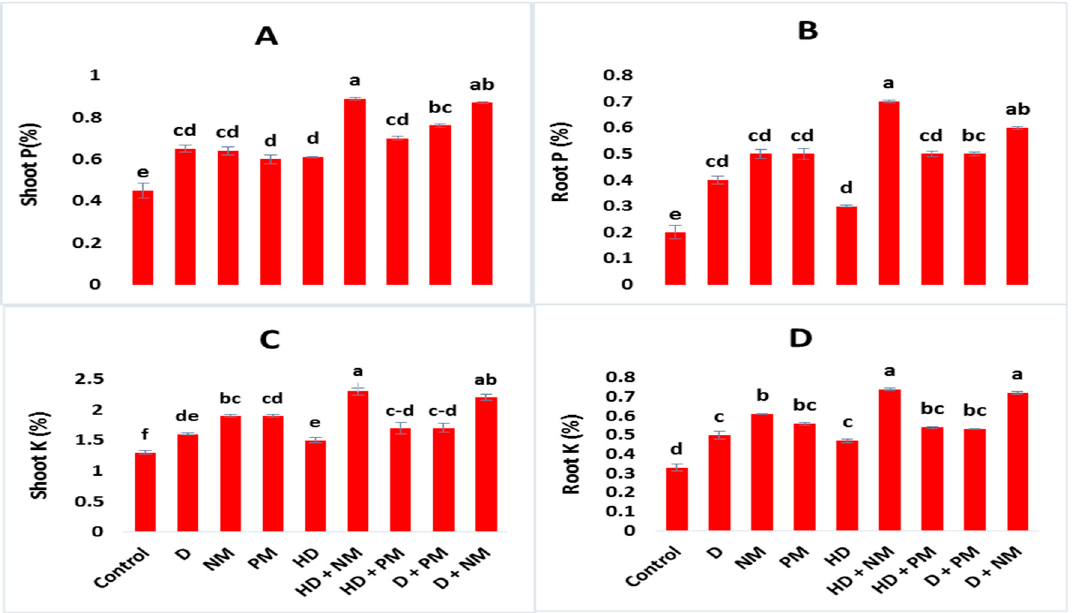
Figure 4. Effect of animal manures with DAP fertilizer plant minerals contents of chickpea ( A ) shoot phosphorus contents, ( B ) root phosphorus content, ( C ) shoot potassium content and ( D ) root potassium content of chickpea D: Recommended DAP; NM: Normal manure; PM: Processed manure; HD: Half of the recommended dose of DAP. Figure bars are showing the mean values ( n = 3). All means followed by different letters have statistically significant differences according to Tukey’s HSD test at probability level of 0.05.